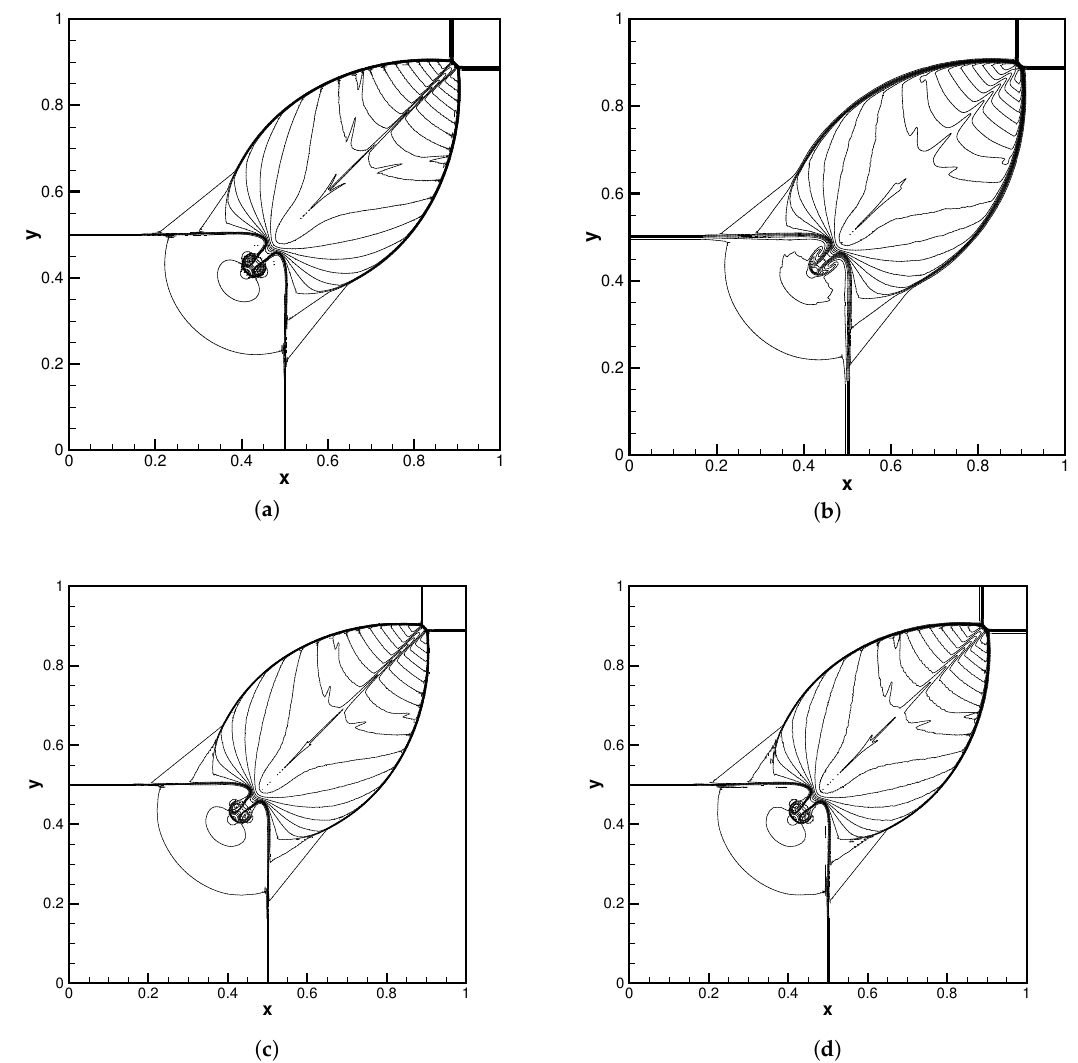
Figure 20. Density solution for the two-dimensional Riemann problem (Case 12) with 160 × 160 P 4 elements at t = 0.25. Thirty-one equally spaced contours from 0.515 to 1.665. ( a ) DB; ( b ) MDH; ( c ) MDA; ( d )